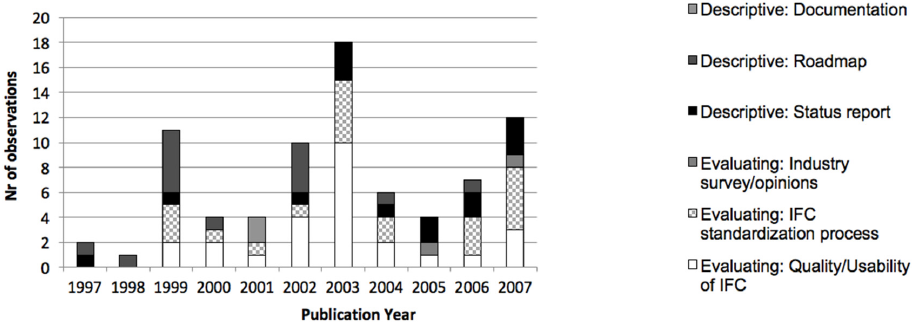
Figure 6. Non ‐ applied research: Descriptive and evaluating research. Figure 6. Non-applied research: Descriptive and evaluating